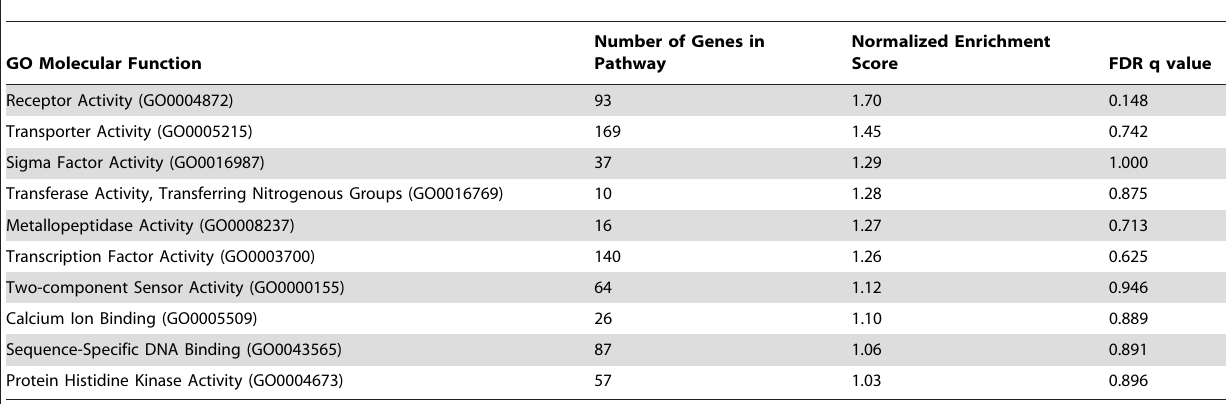
Table 3. GO Molecular Functions that are Enriched with Genes Upregulated in B. theta from Monoassociated HLA-B27 Tg Rats.